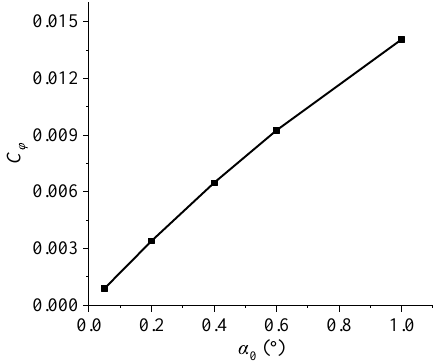
Figure 7. The flow rate coefficient at different guide vane openings during the pump mode’s starting up process.